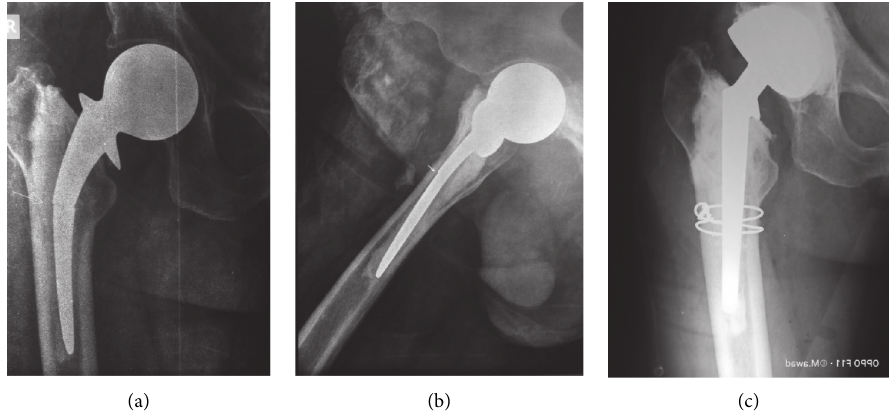
Figure 3: Preoperative and postoperative plane X-ray of a case with broken Thompson prosthesis. Removal of the broken stem by lateral bone window and revision by cemented dual mobility cup and DDH cemented stem.